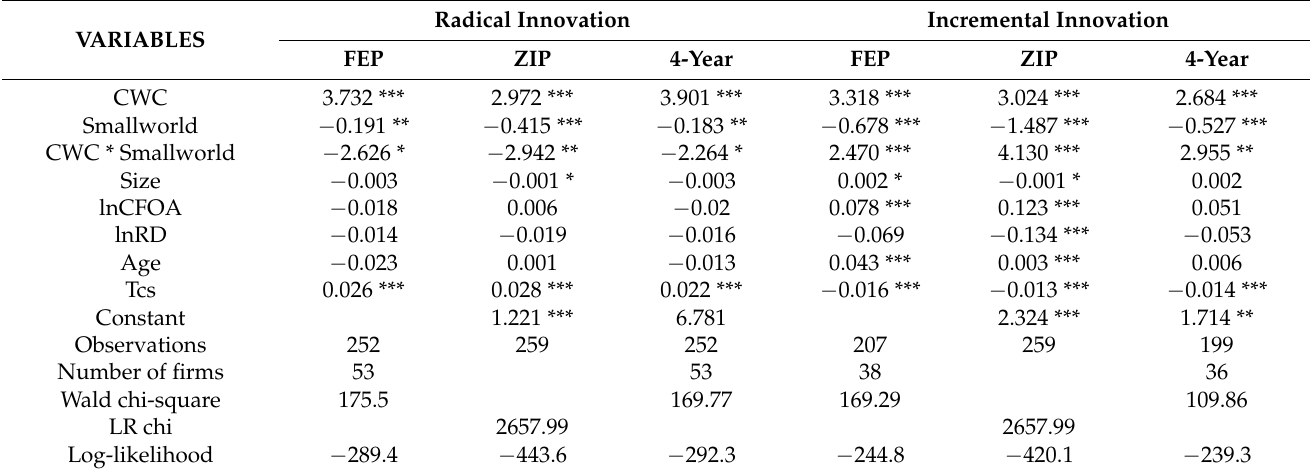
Table 4. Robustness